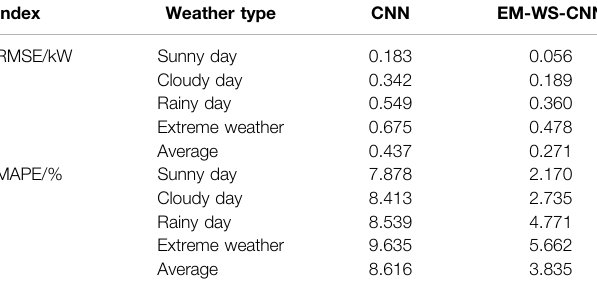
TABLE 3 | RMSE and MAPE of four weather